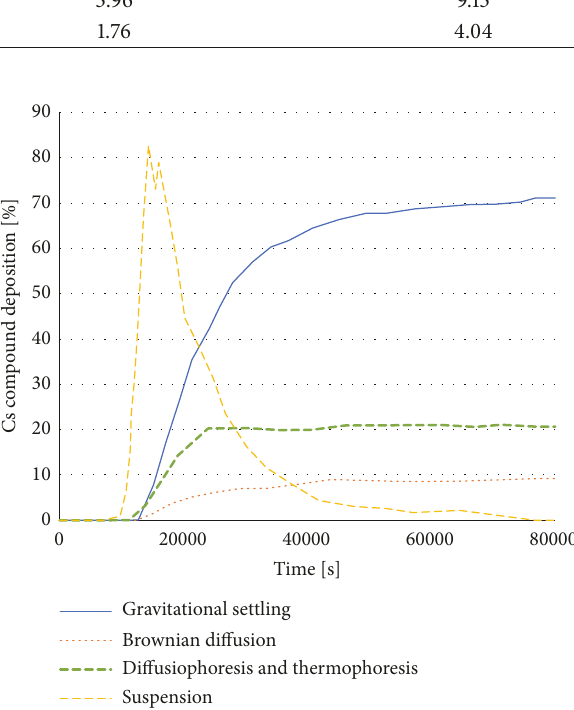
Figure 9: Steam flow rates of containment zone, dry condenser zone, and wet condenser zone from RELAP5 Mod 3.3.